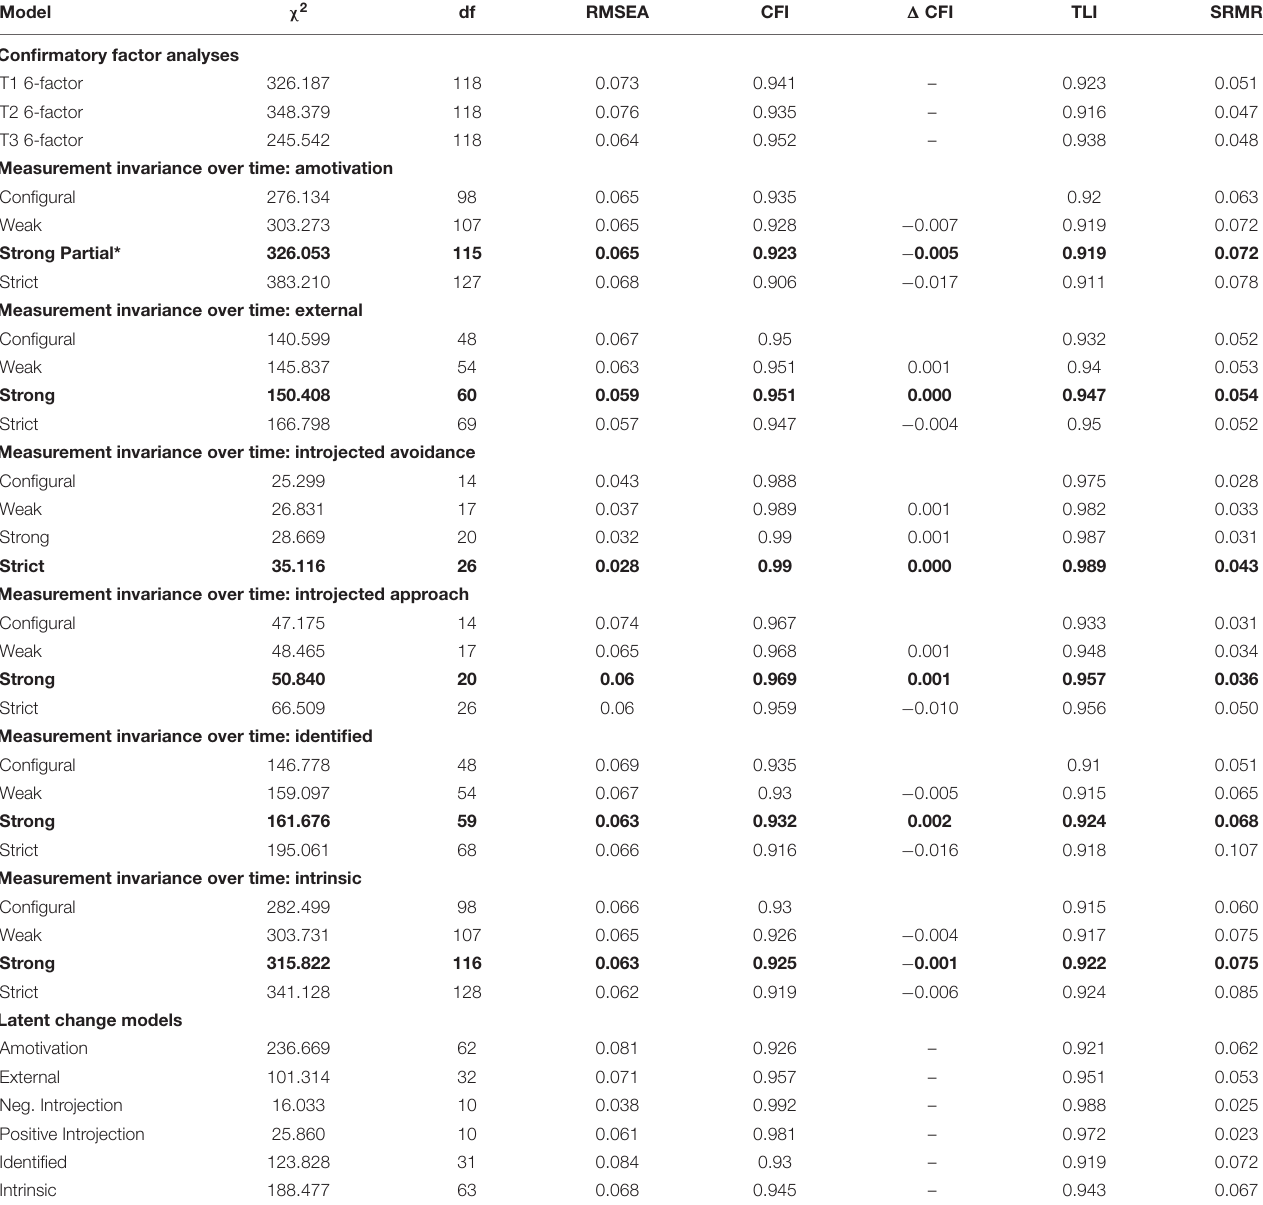
TABLE 1 | Fit Statistics for confirmatory factor analysis, measurement invariance, and latent change models.